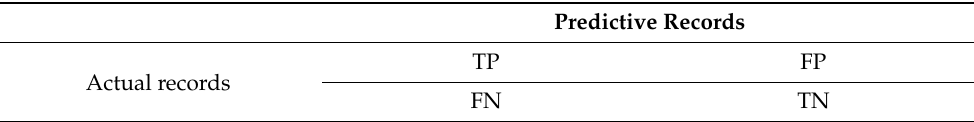
Table 2. Confusion